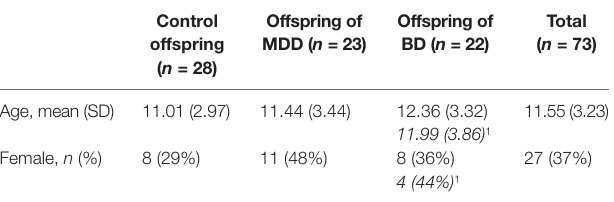
TABLE 1 | Demographic and clinical information for the